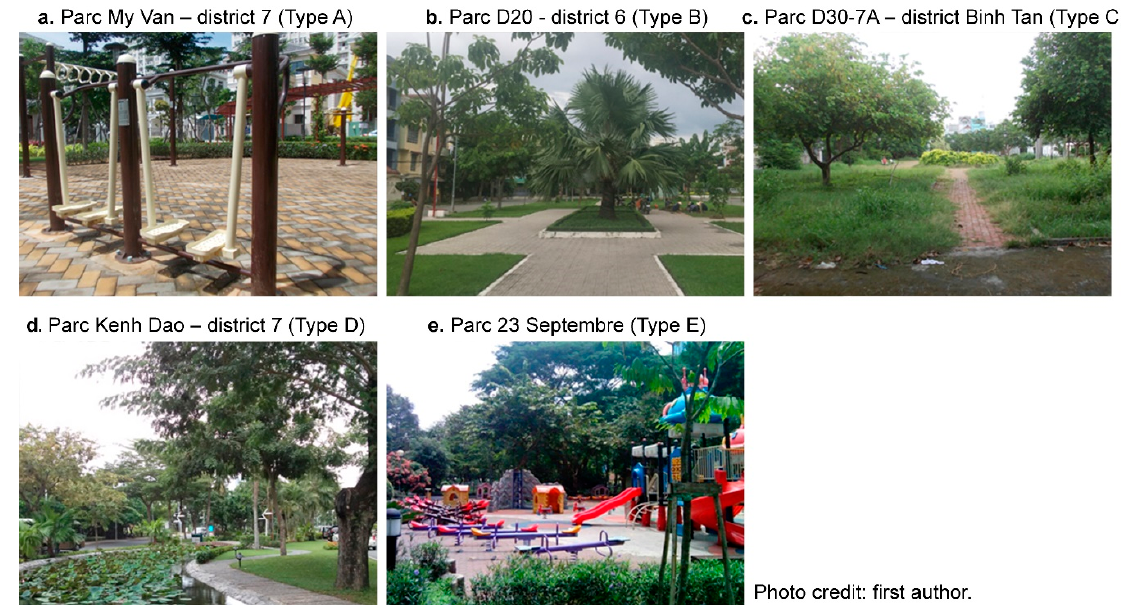
Figure 3. Examples of parks according to the typology obtained.